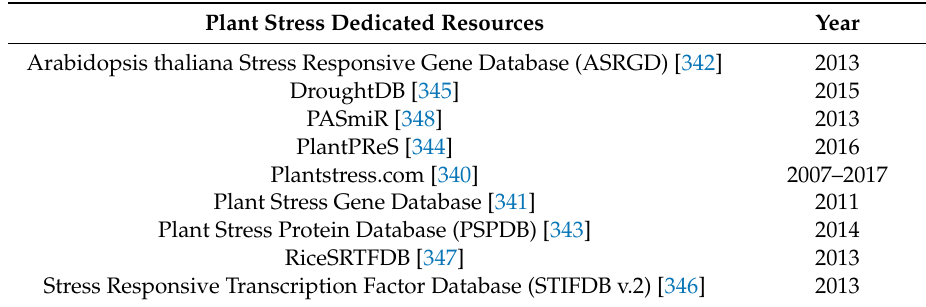
Table 6. “Abiotic stress”-related databases and platforms publicly